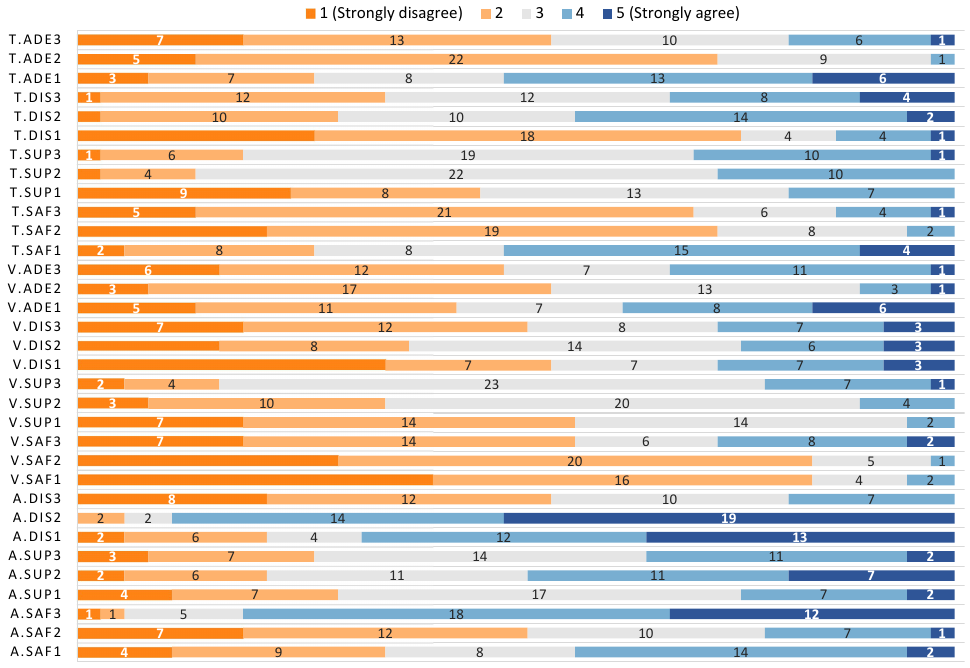
Figure 9. Distribution of responses for each question for the experiment with younger